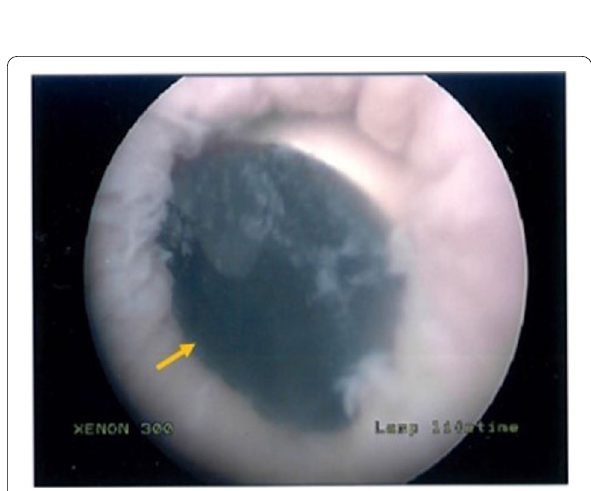
Fig. 2 Urethroscopy before the removal of the foreign bodies